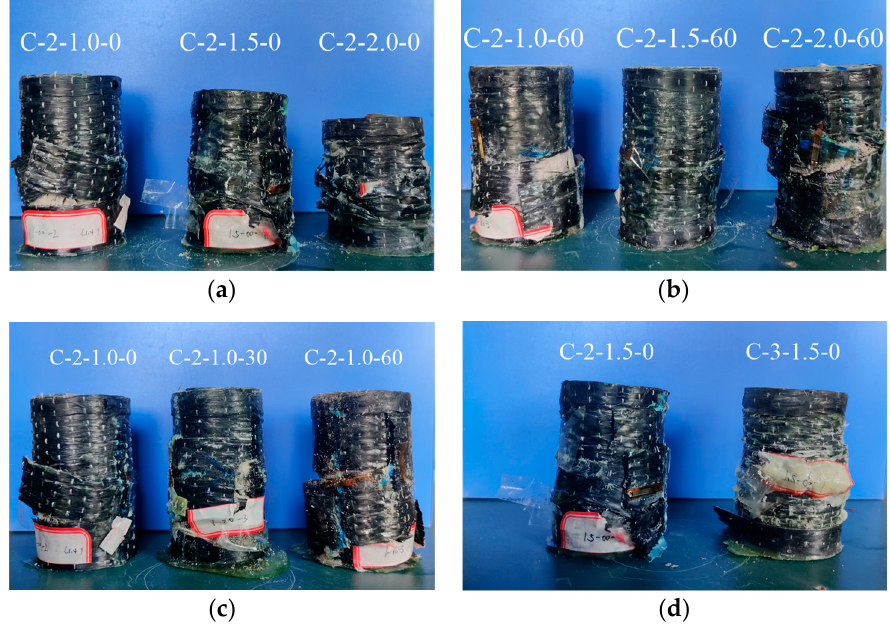
Figure 7. Typical failure mode of SBM specimens: ( a ) Series 1; ( b ) Series 2; ( c ) Series 3; ( d ) Series 4.